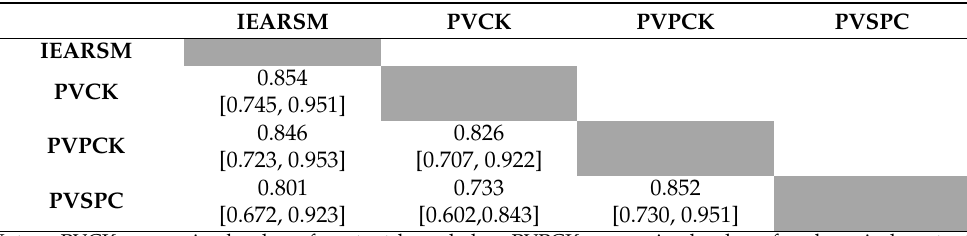
Table 4. Discriminant validity based on HTMT 0.90